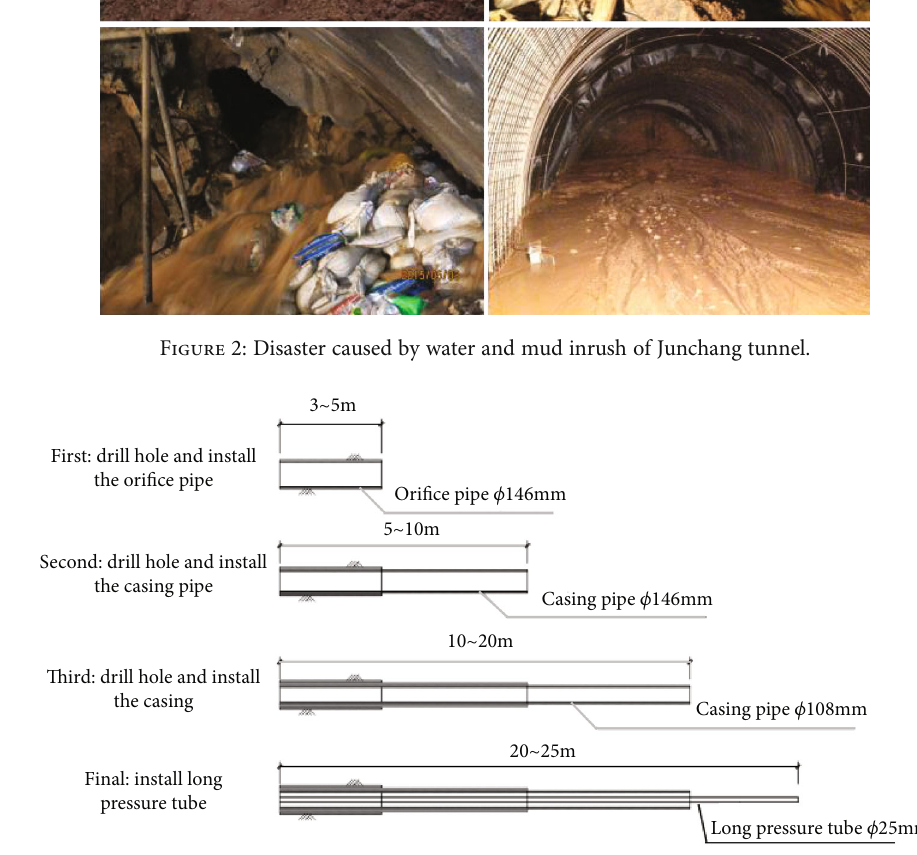
Figure 3: Schematic diagram of section